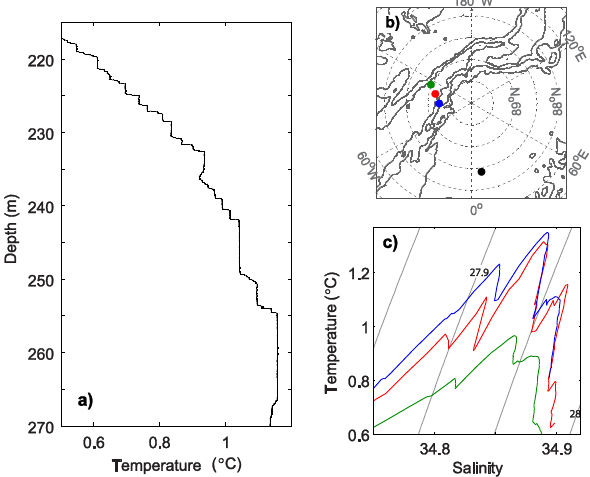
Figure 12. An example temperature profile (a) , collected using a microstructure profiler, showing the staircase structure in the Amundsen Basin in the Arctic Ocean (station shown by black bullet point in (b) ). Map showing the isobaths (1000m contour interval) of the Lomonosov Ridge and station locations of (a) and (c) in corre- sponding colours (b) . Temperature and salinity diagram from three profiles across the Lomonosov Ridge. The grey isolines show the water potential density subtracted by 1000kgm − 3 (c)